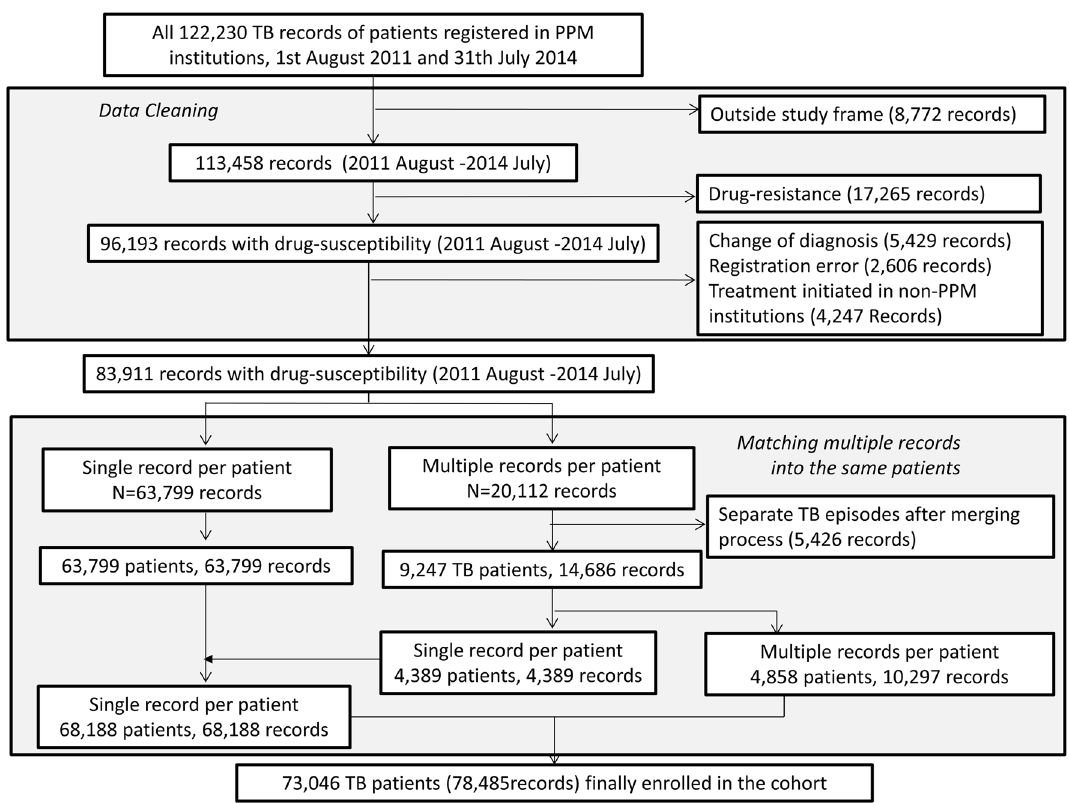
Figure 1. Patient enrolment flow chart. After applying exclusion criteria, 83,911 records were classified into those with a single notification per patient and those with multiple notifications. After merging the records of the latter into the one outcome, a total of 73,046 patients (78,485 records) were finally enrolled in this study. TB tuberculosis, PPM public–private mix.